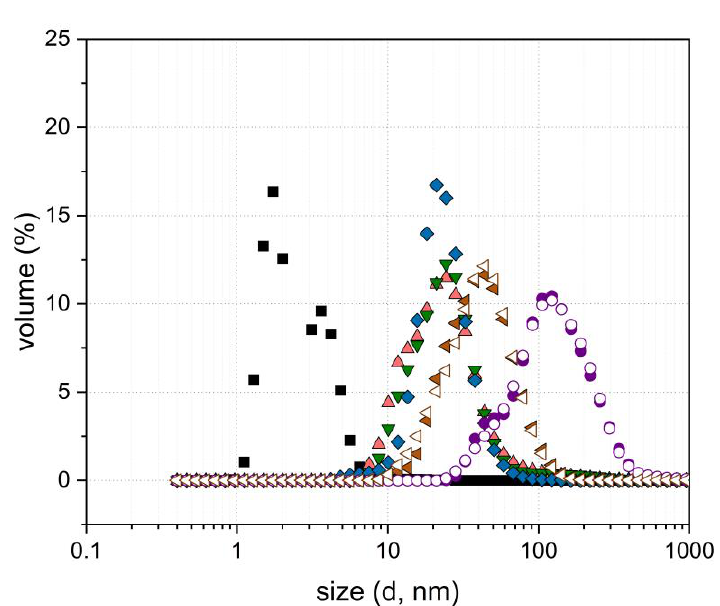
Figure A1. Particle size distribution curves of β -Lg particles (c = 8.2 g L − 1 , pH 6.8) after purification (heating conditions (pH / NaCl): ■ pH 8.5 / 0 mM, ◆ pH 6.8 / 0 mM, ◀ pH 6.2 / 0 mM, ● pH 5.8 / 0 mM, ▼ pH 6.8 / 20 mM, and ▲ pH 8.5 / 60 mM). Non-filled symbols indicate an additional variation in the pH value (i.e., pH ≠ 6.8) after purification ( ◁ pH 6.2 / 0 mM (pH 6.3) and ○ 5.8 / 0 mM (pH 6.2)).